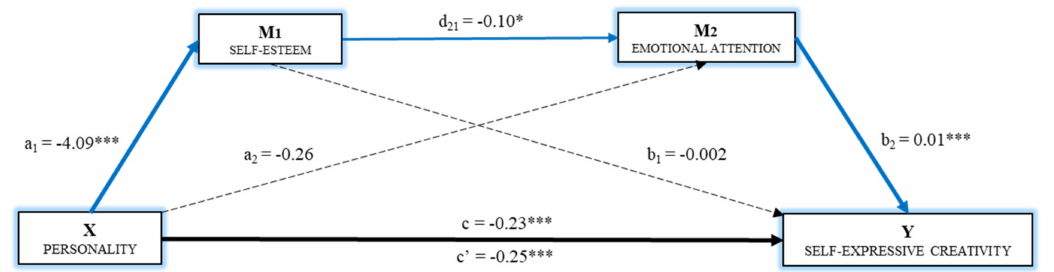
Figure 2. Multiple mediation model of self-esteem and emotional attention on the relationship between personality and self-expressive creativity (Note. * p < 0.05, *** p < 0.001. Non-standardized regression coe ffi